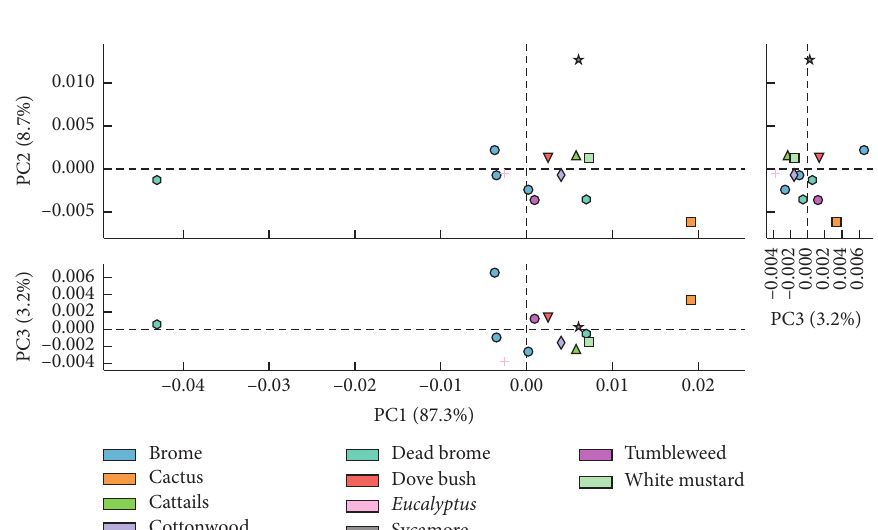
Figure 10: Principal coordinate analysis of functional profiles color-coded by plant